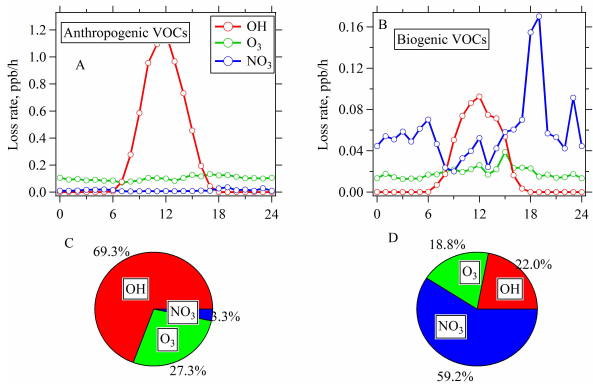
Fig. 2. Diurnal variations of loss rates of anthropogenic (A) and bio- genic (B) VOCs from reactions with OH radical, NO 3 radical and ozone. The fractions in 24h averaged loss rates of anthropogenic (C) and biogenic (D) VOCs consumed by the three different oxi-